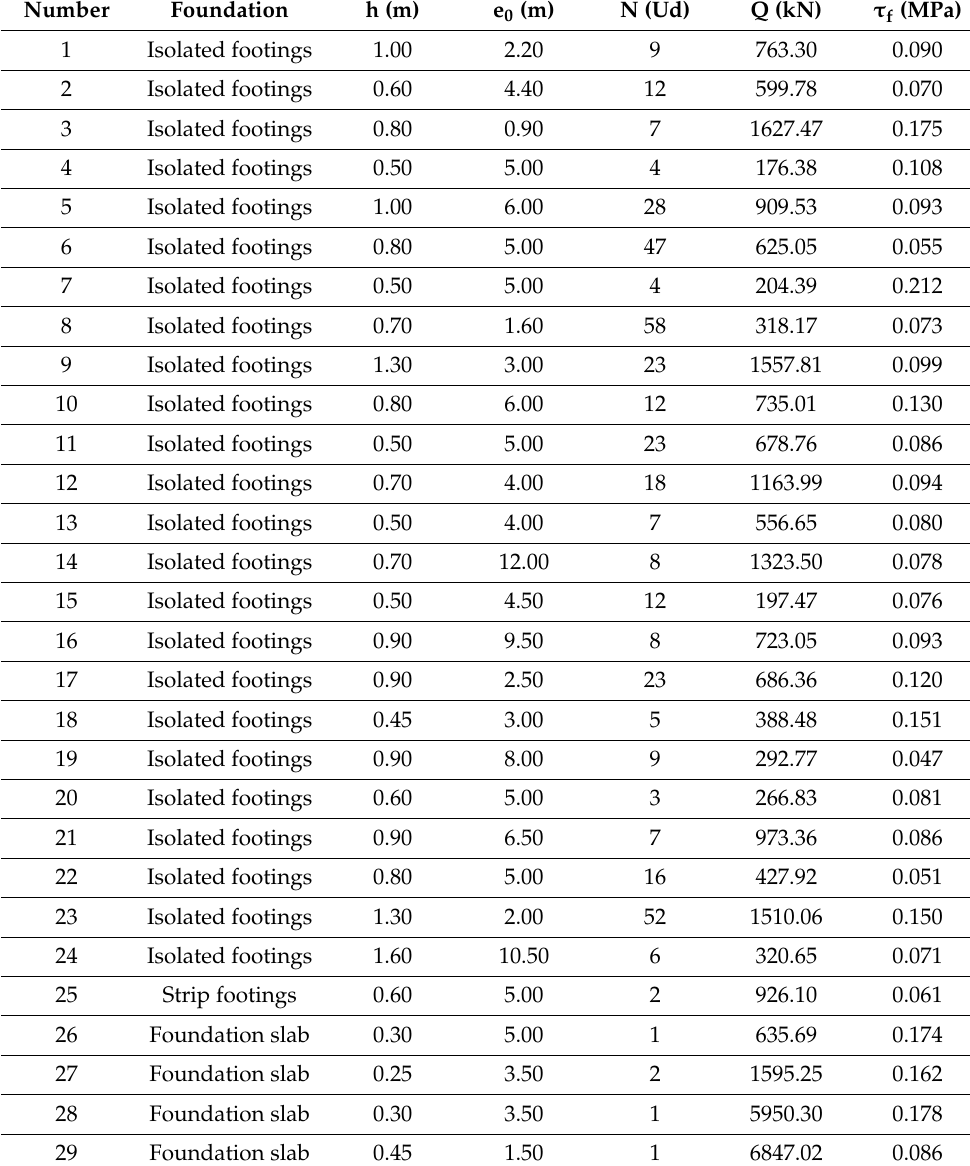
Table 2. Characteristics of the building’s